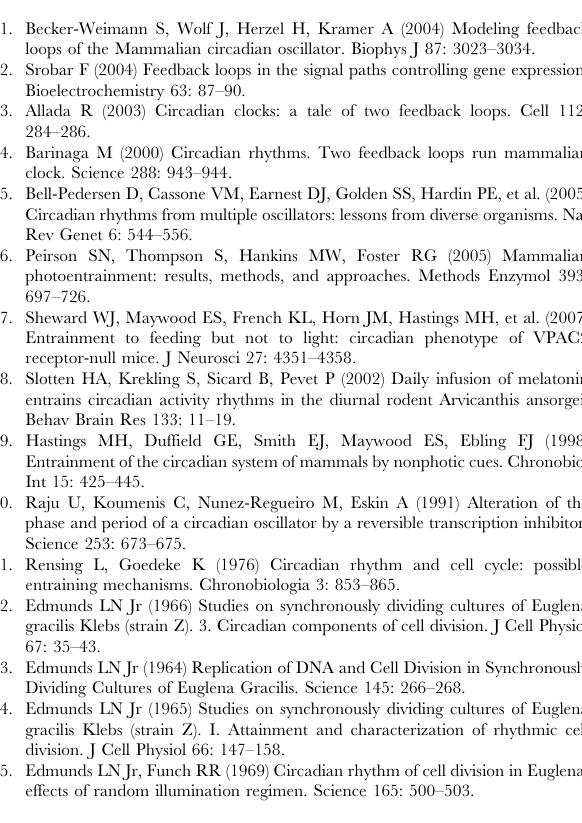
the Materials and Methods section. The magnitude of the noise is controlled by s . Figure S4 Molecular processes included in the mammalian circadian models we used in this study (adapted from [30]). Ovals represent proteins and rectangulars represent mRNA transcription. Black elements denote protein degradation. cyto(-) and nuc(-) represents cytoplasmic and nuclear proteins respective- ly. -P denotes protein phosphorylation. Lines with arrows means protein phosphorylation and dephosphorylation activation or transcriptional activation, while lines with bars means inhibition. The green colored molecules at the upper-left corner are only included in the 19 equation models, while the light blue colored molecules are included in both mammalian models. Found at: doi:10.1371/journal.pcbi.1000019.s004 (0.42 MB TIF) Text S1 ODE file for the mammalian circadian model incorporating transcriptional inhibition. Found at: doi:10.1371/journal.pcbi.1000019.s005 (0.01